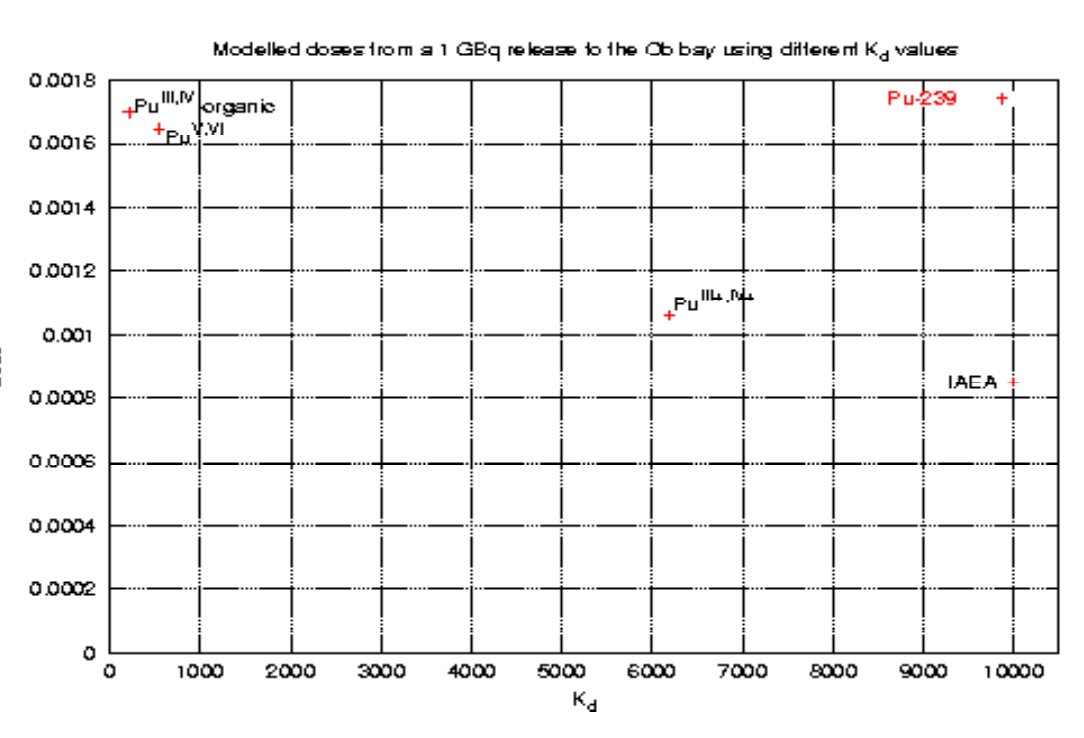
PU IN OB AND YENISEY ESTUARIES AND YENISEY